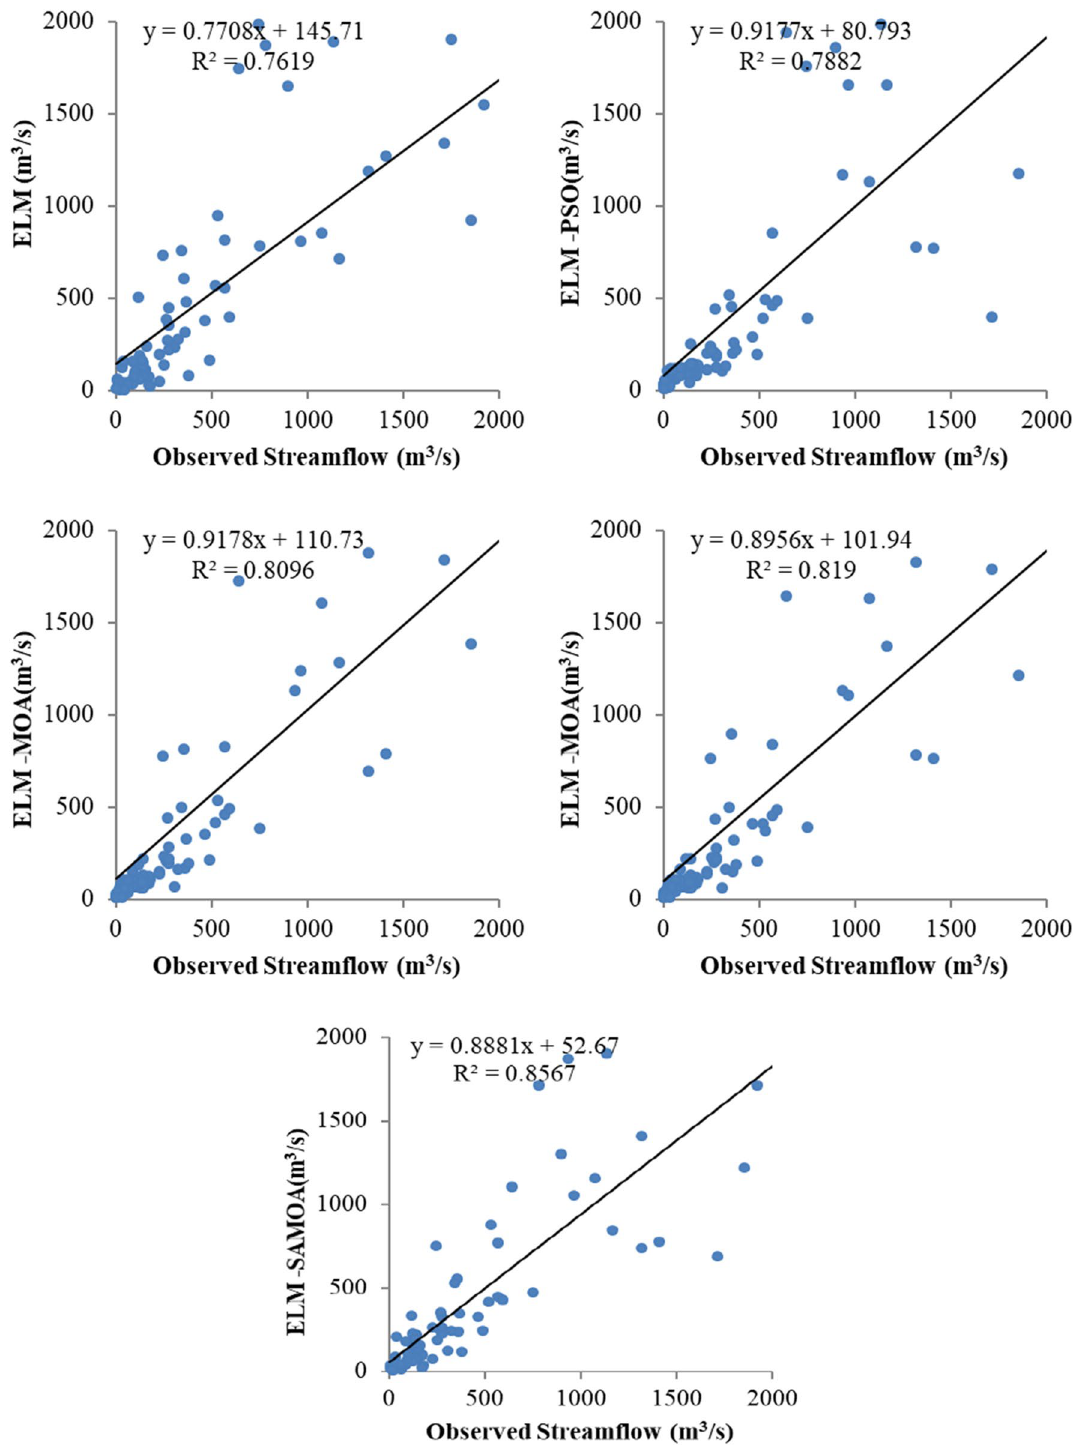
Fig. 8 Scatterplots of the observed and predicted streamflows different ELM-based models in the test period of